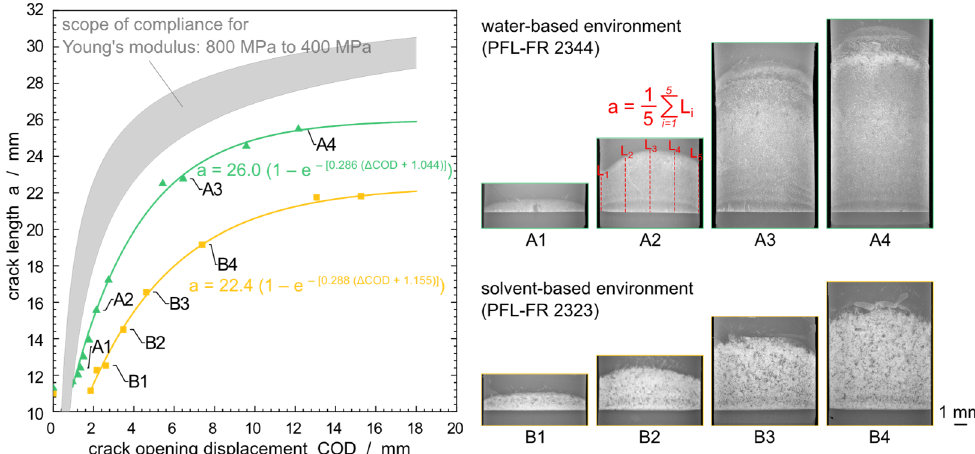
Figure 4. Standard polynomial compliance function, shaded gray, for Young’s modulus range of 800 MPa to 400 MPa (Young’s modulus of PE-HD at 40 °C). Experimental calibration function (exponential function fit) measured by cryogenic fracture of prematurely removed specimens in PFL-FR 2344 (green), and pre-saturated and measured in PFL-FR 2323 (yellow). Example fracture surfaces in LM from both environmental media with crack length 𝑎 determination.